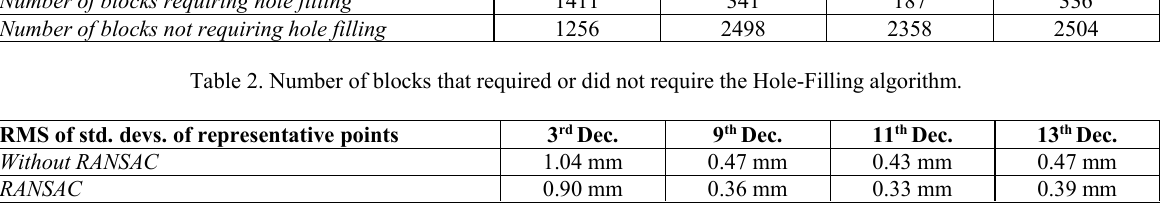
Table 3. RMS (Root Mean Square) of std. devs. for representative points’ coordinates as obtained with and without filtering with